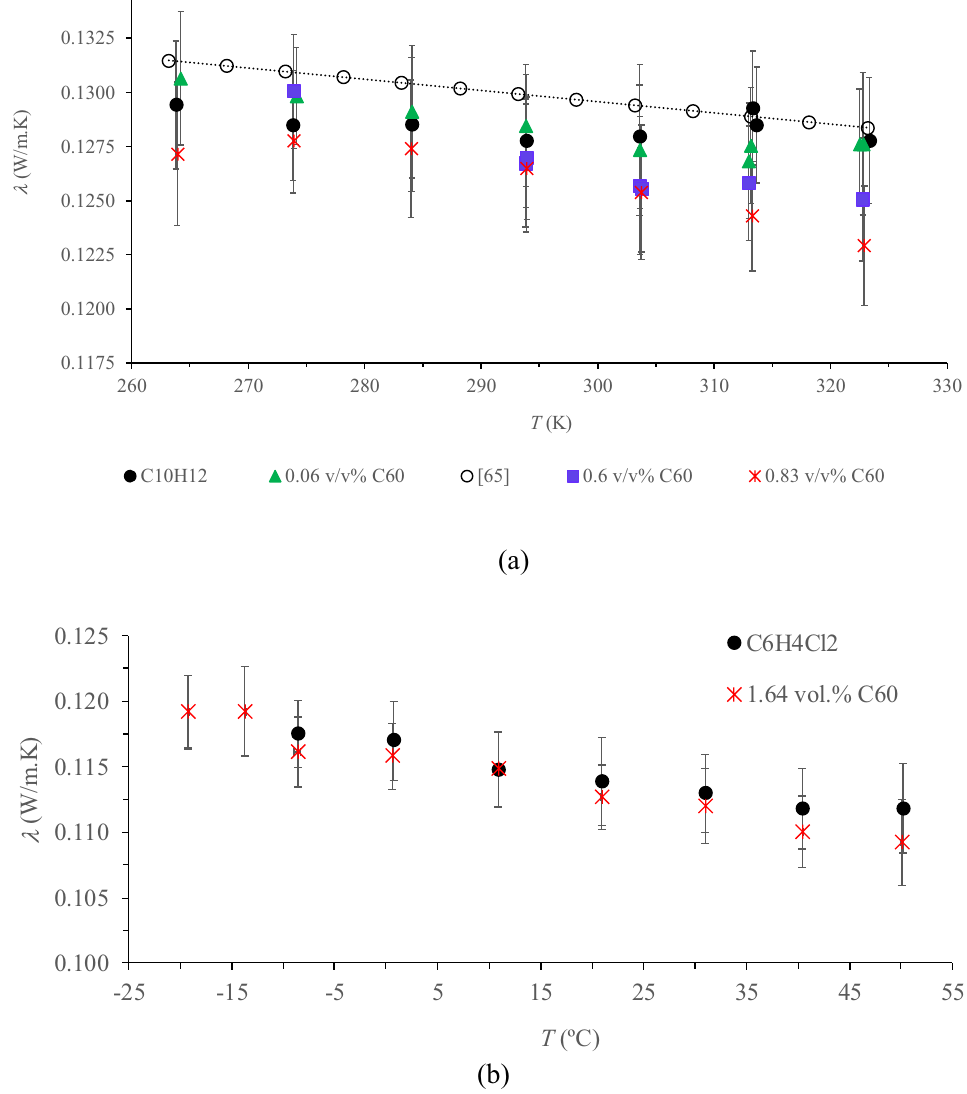
Figure 1. Measured λ of C 60 NFs and base liquids C 10 H 12 ( a ) and C 6 H 4 Cl 2 ( b ) as a function of temperature ( T ). Microsoft Excel 2016 was used to generate these